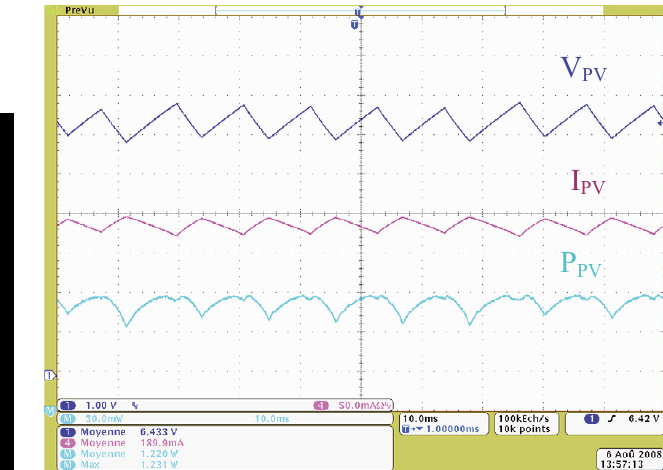
Fig. 5. Experimental steady state behavior of PV array vari- ables controlled by a Boost with Extremum-Seeking MPPT control.